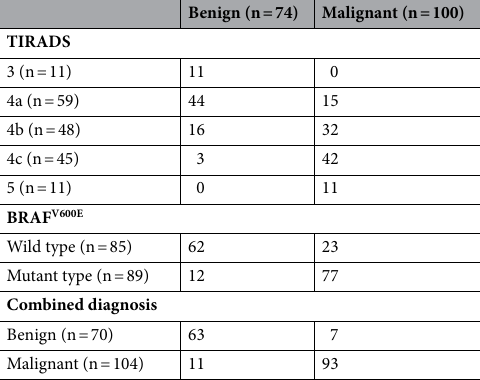
Table 2. The specific information of Bethesda categories III–V thyroid nodules adopting TIRADS, BRAF V600E and combined